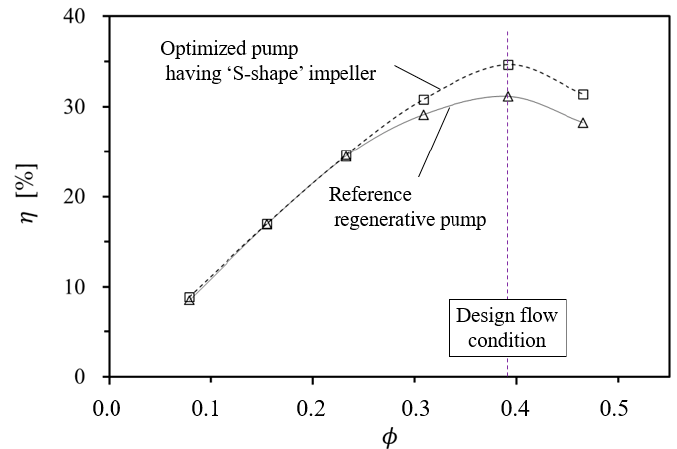
Figure 13. Performance comparisons of the reference pump and the optimized pump with an ‘S-shape’ impeller from numerical simulations.